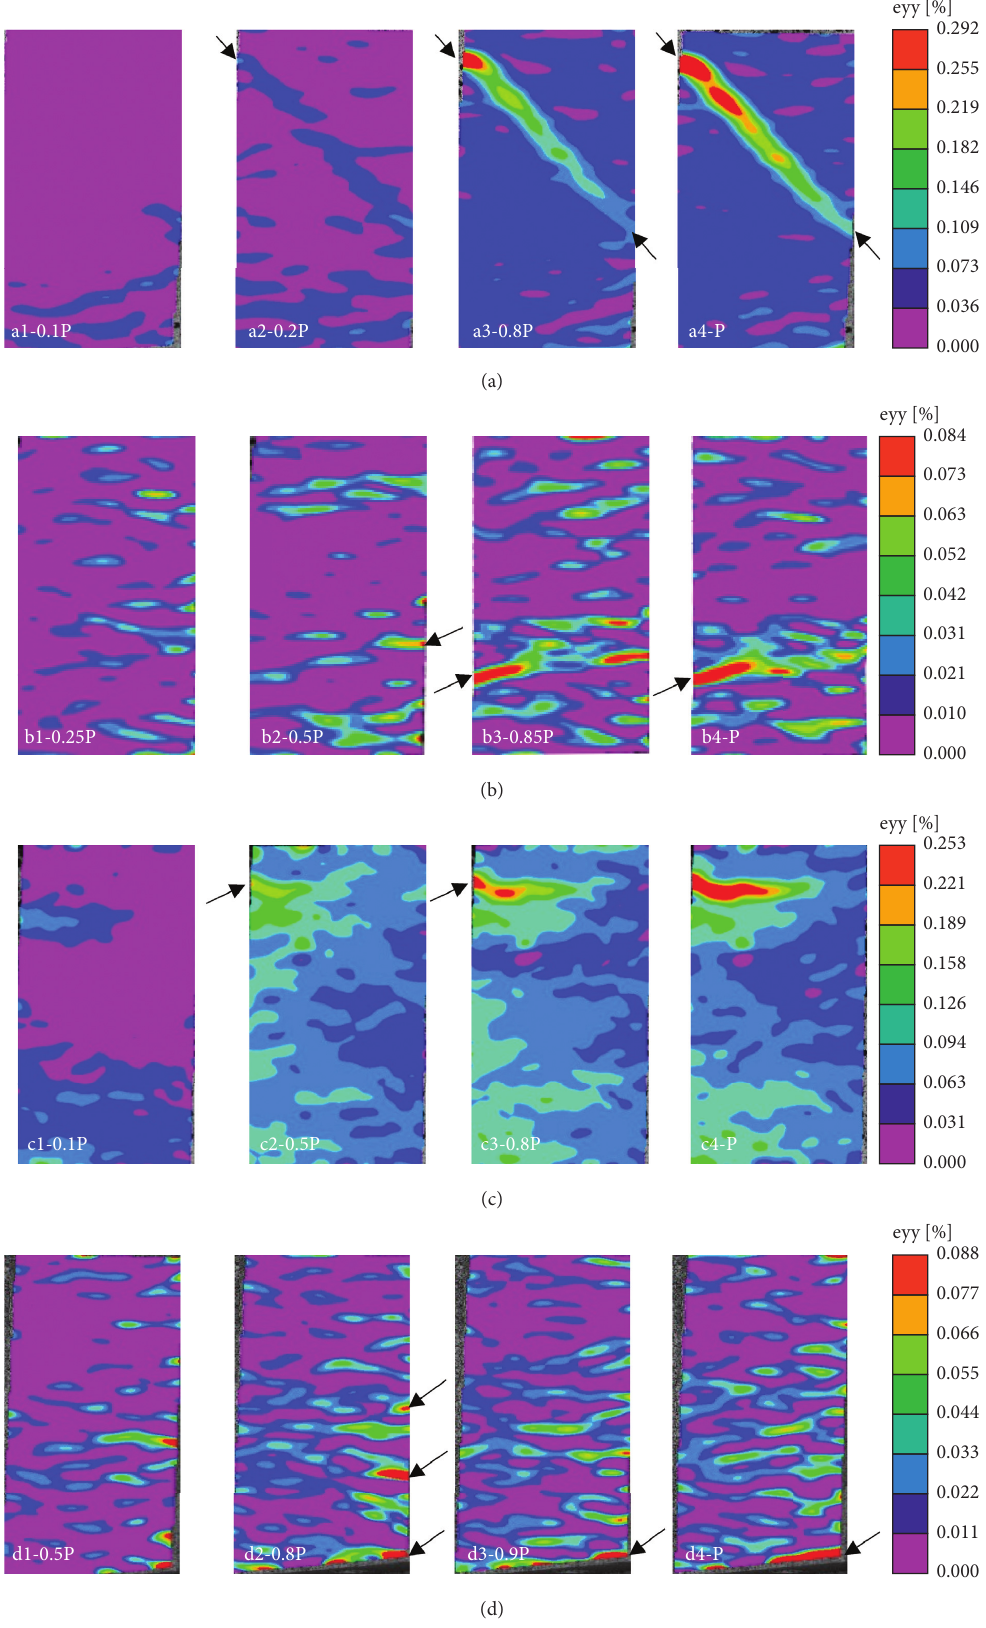
Figure 7: Vertical strain field for specimen with various fibers at different loading stages: (a) C50-C50-BG-45 ° (primary surface), (b) SC50- C50-BG-45 ° (primary surface), (c) PC50-C50-BG-45 ° (primary surface), and (d) SPC50-C50-BG-45 ° (primary